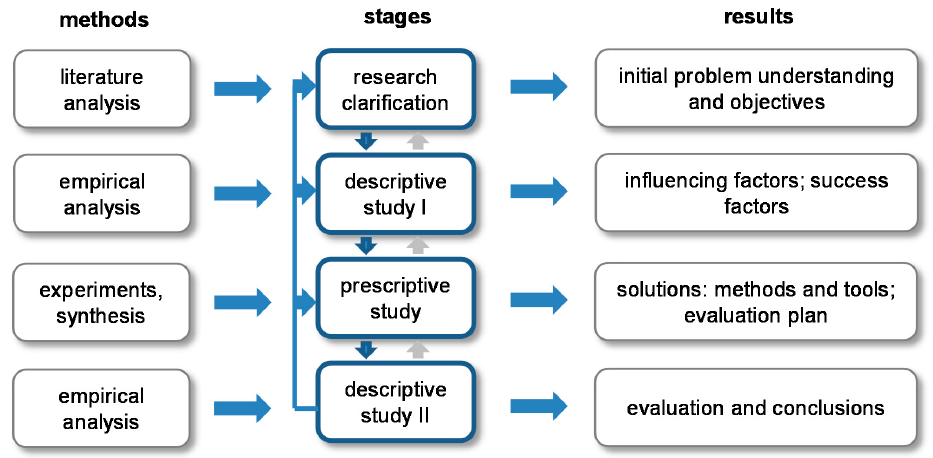
Figure 3. Four stages of the design research methodology (compare [4] and [5]).